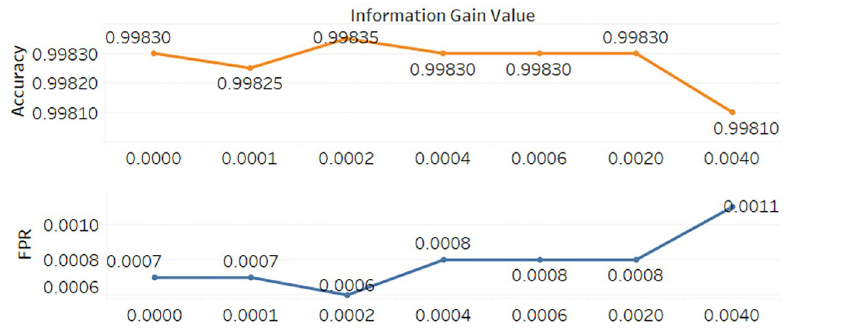
Fig 4. Classification results among different feature sets.